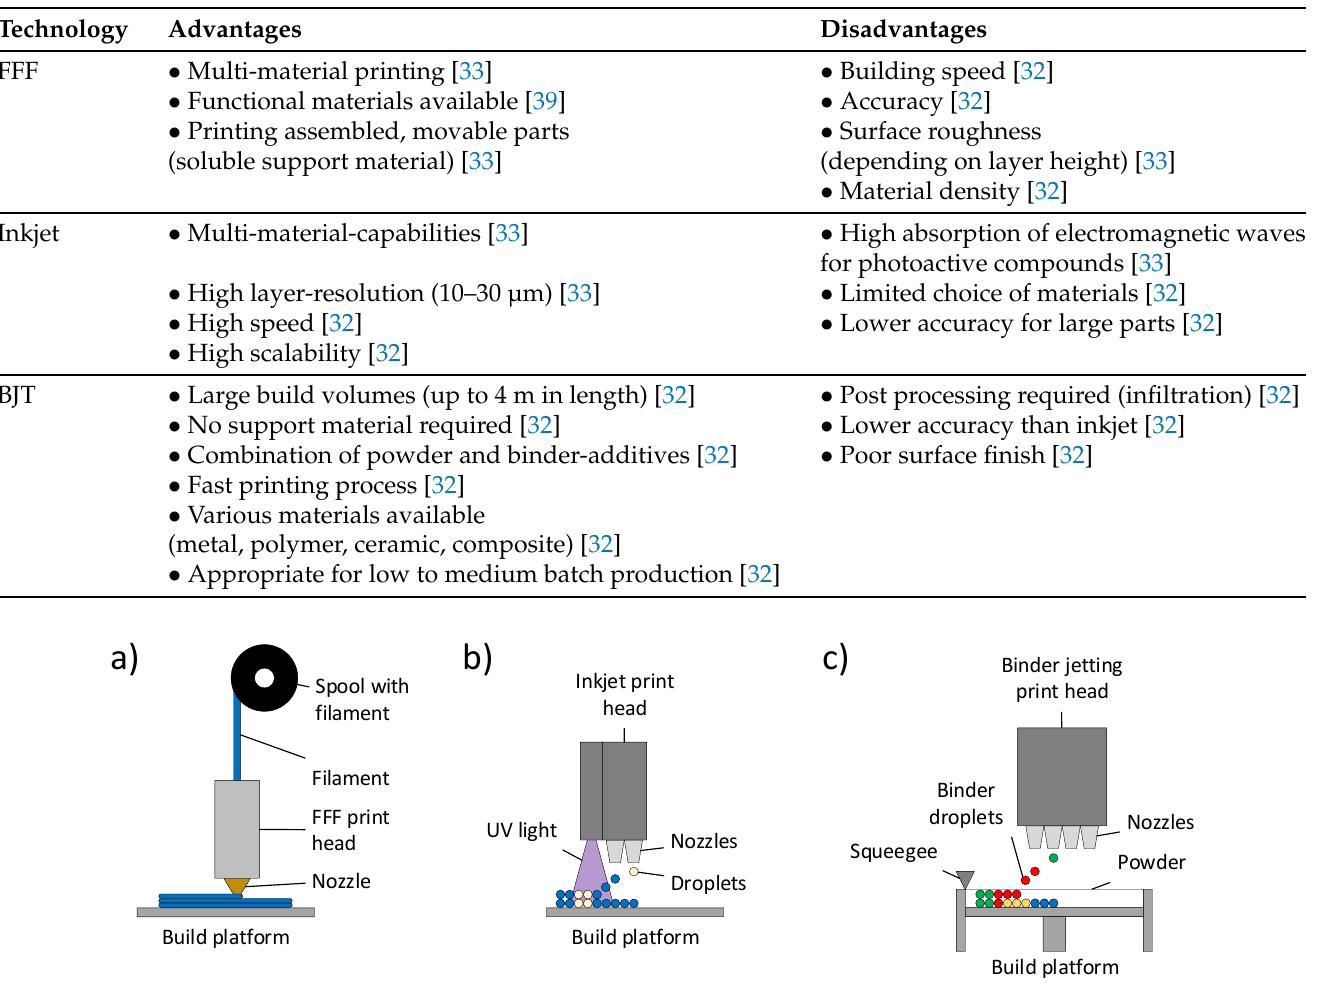
Figure 2. Schematic printing processes, ( a ) FFF with one extruder, ( b ) inkjet with photopolymers (blue = model material, beige = support material), ( c ) binder jetting with multiple